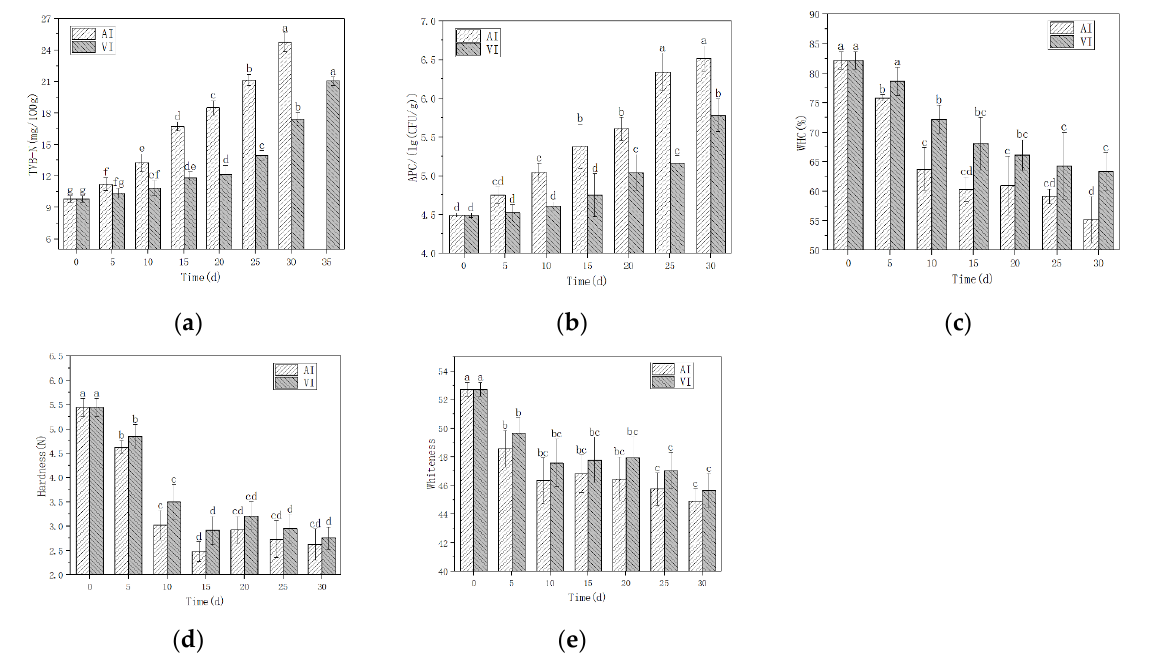
Figure 4. Graph of quality parameter change compared between VI and AI with combined preserv- ative during storage at −2 °C. ( a ) TVB-N values; ( b ) aerobic plate count values (APC); ( c ) water- holding capacity values (WHC); ( d ) hardness; ( e ) whiteness. Note: Different lowercase letters indi- cate significant differences between groups with different storage storage days ( p < 0.05).